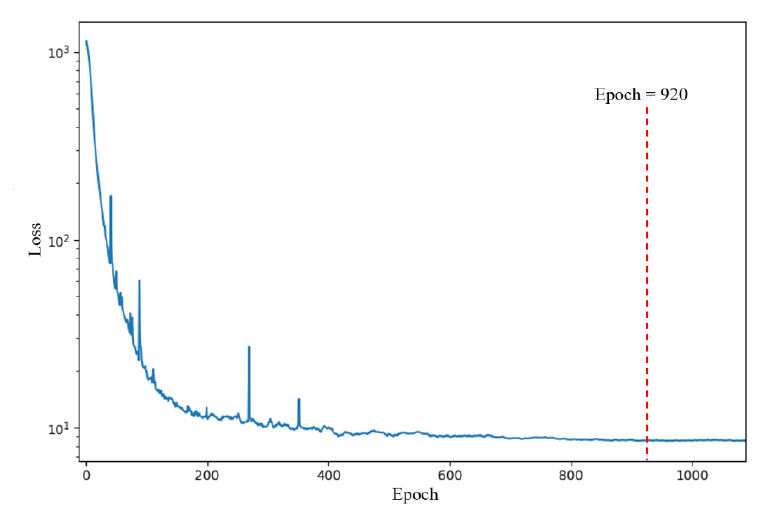
Figure 6. Training loss curve of the 1DCNN framework during training in Experiment